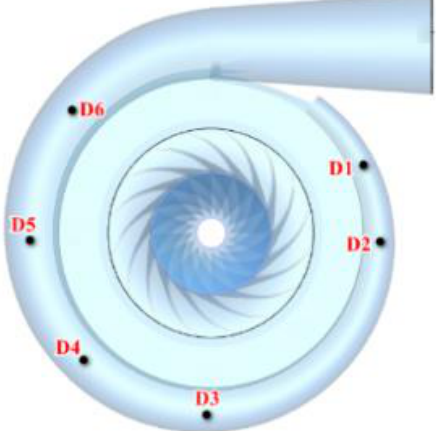
Figure 19. Monitoring points in the volute .